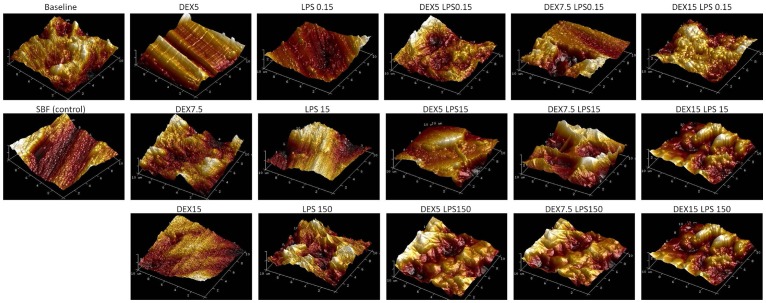
3D AFM images of the Ti-6Al-4V alloy with an acid-etched surface.Surfaces were characterized before (baseline) and after corrosion in SBF (control) with different concentrations of dextrose (DEX) and lipopolysaccharide (LPS), alone or in association (DEXLPS).